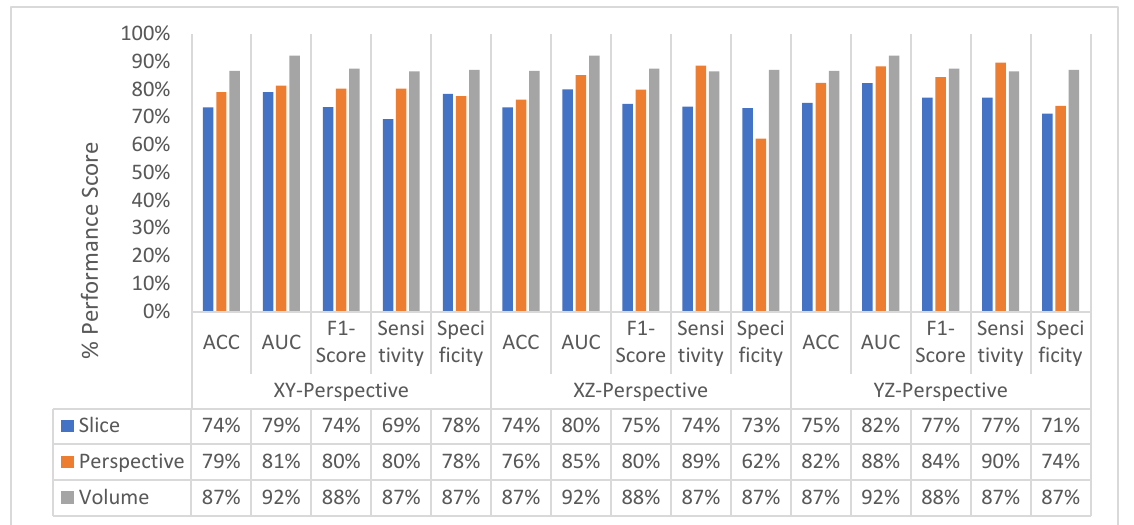
Figure 16. MPF model—Change in classification performance for slice, perspective, and volume-level classifications for each perspective.